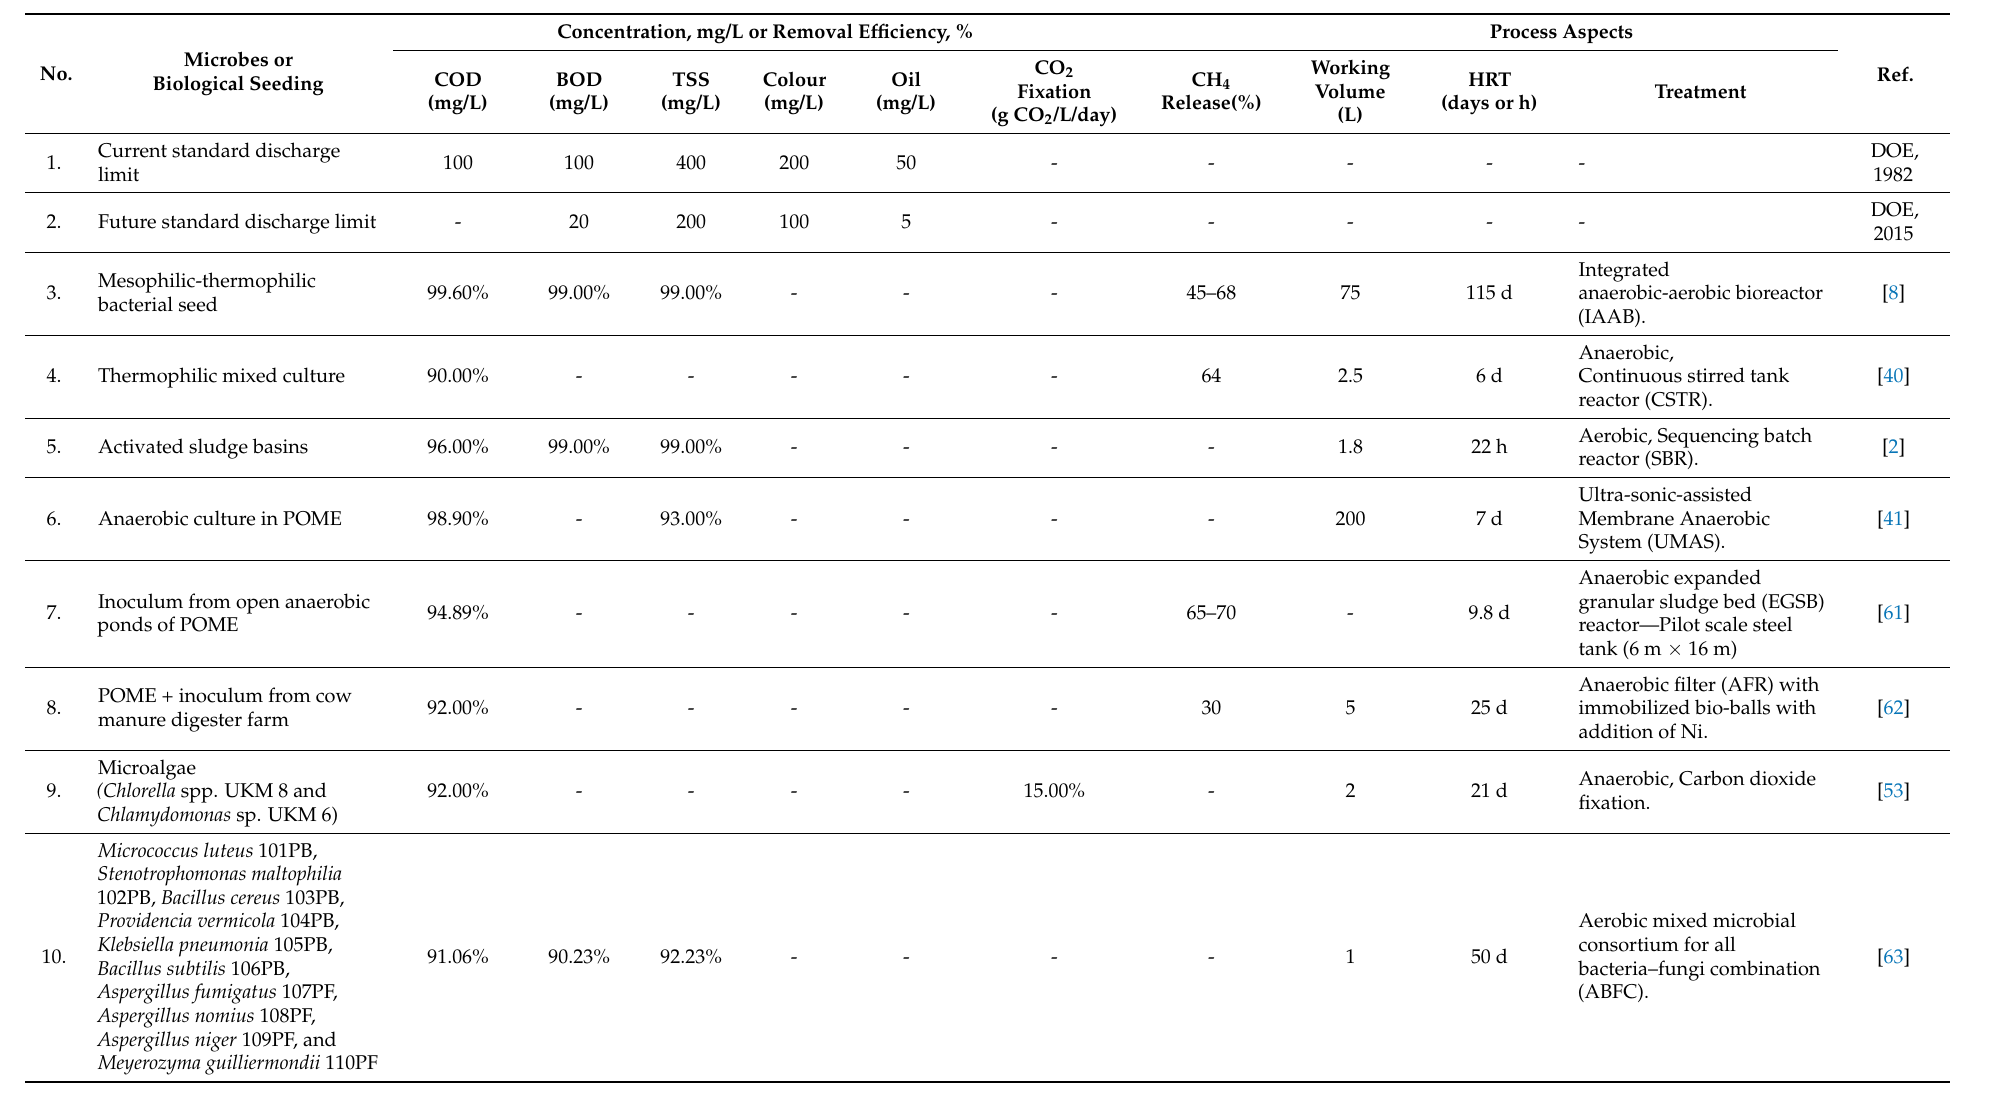
Table 2. Summary of various biological treatment techniques for